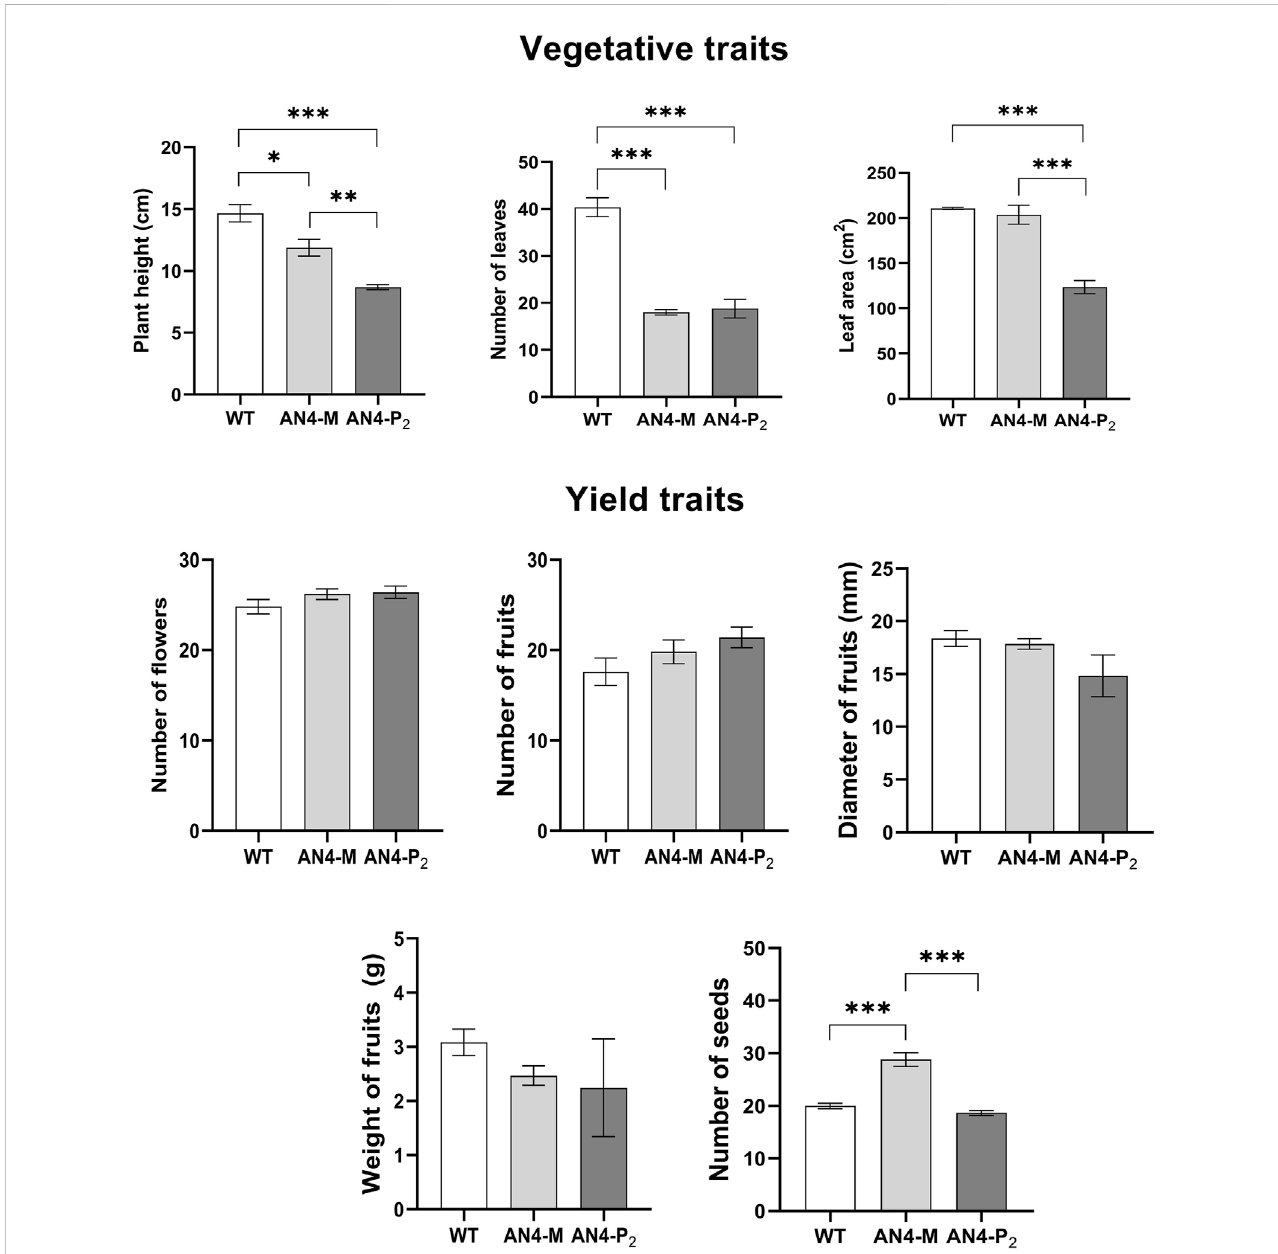
FIGURE 2 Comparedmorphometricanalysisamongwildtype,AN4-P2andAN4-Mplants.Means±SE( n =5replicates).Statisticalrelevance:*: p < .05;**: p < .001; ***: p <